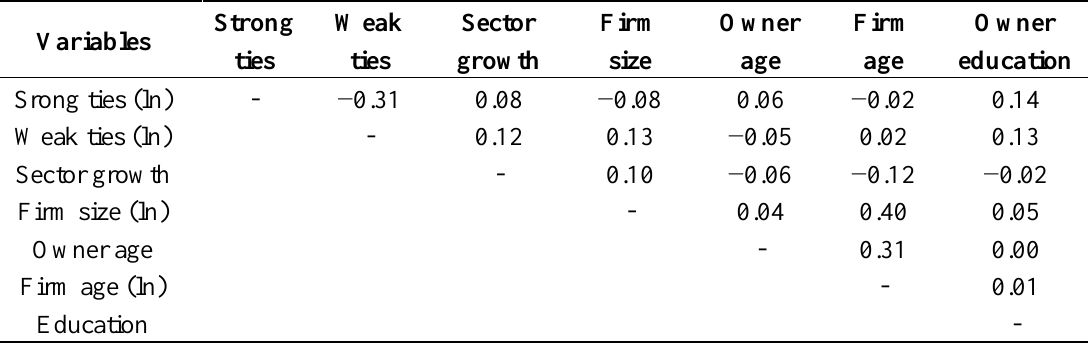
Table 1. Correlations among independent and control